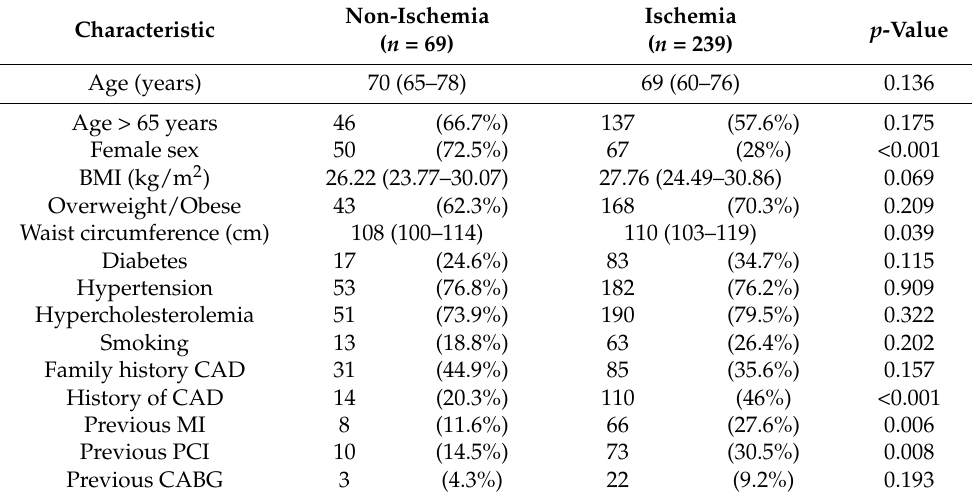
Table 1. Baseline characteristics according to the absence or presence of ischemia in myocardial